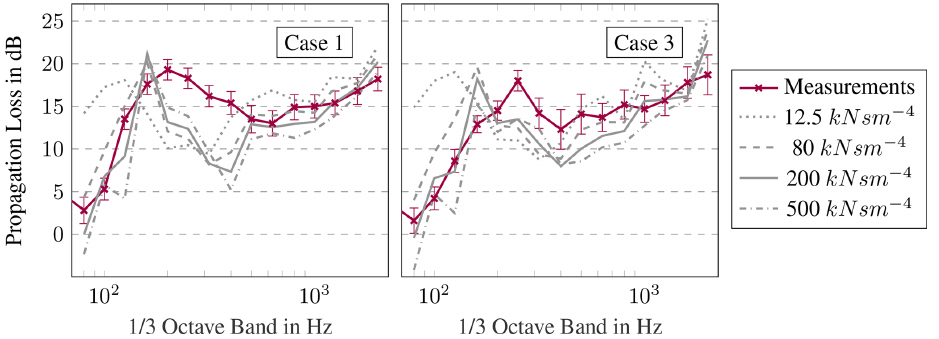
Figure 13. Comparison of measured and modelled sound propagation losses between 178 and 845m, with representative values of flow resistivity per one-third octave band.